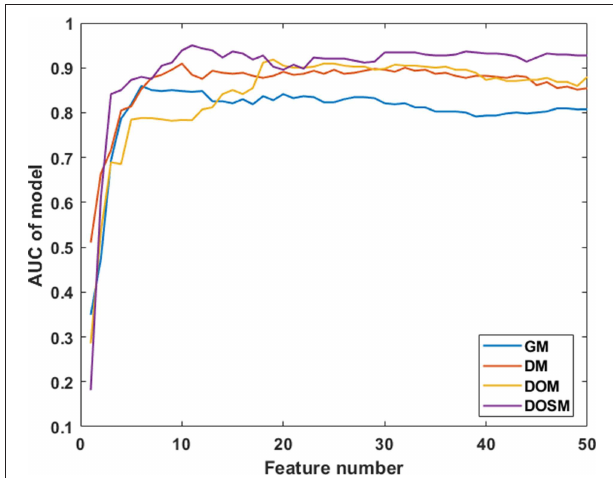
FIGURE 4 | Diagnostic performances of MVI prediction models with different number of features. After feature selection, the performance of DOSM, DOM, DM, and GM models were increased gradually and maintained at a relative stable level. The changes in AUC with the increase in feature numbers were helpful to find the optimal feature dimensions of each model. The final feature dimensions of MVI prediction models of GM, DM, DOM, and DOSM were 6, 10, 19, and 11, respectively.